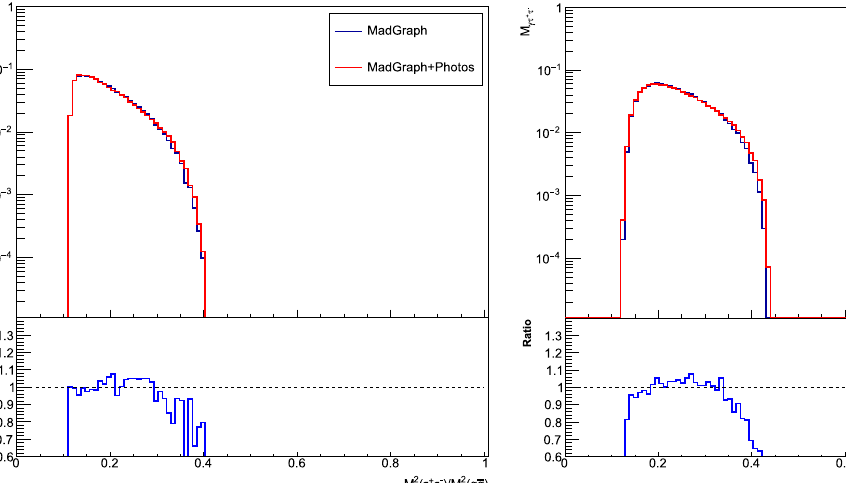
distributions from the two samples generated using MadGraph and √ MadGraph + Photos ; the lower panel shows the ratio of the two s = 10 . 5